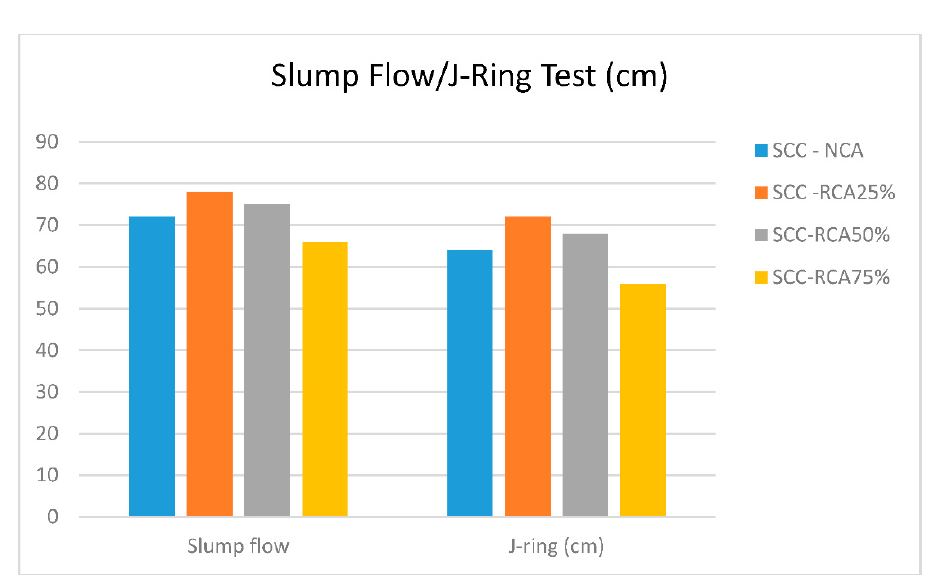
Figure 6. Slump Flow and J-Ring Test.